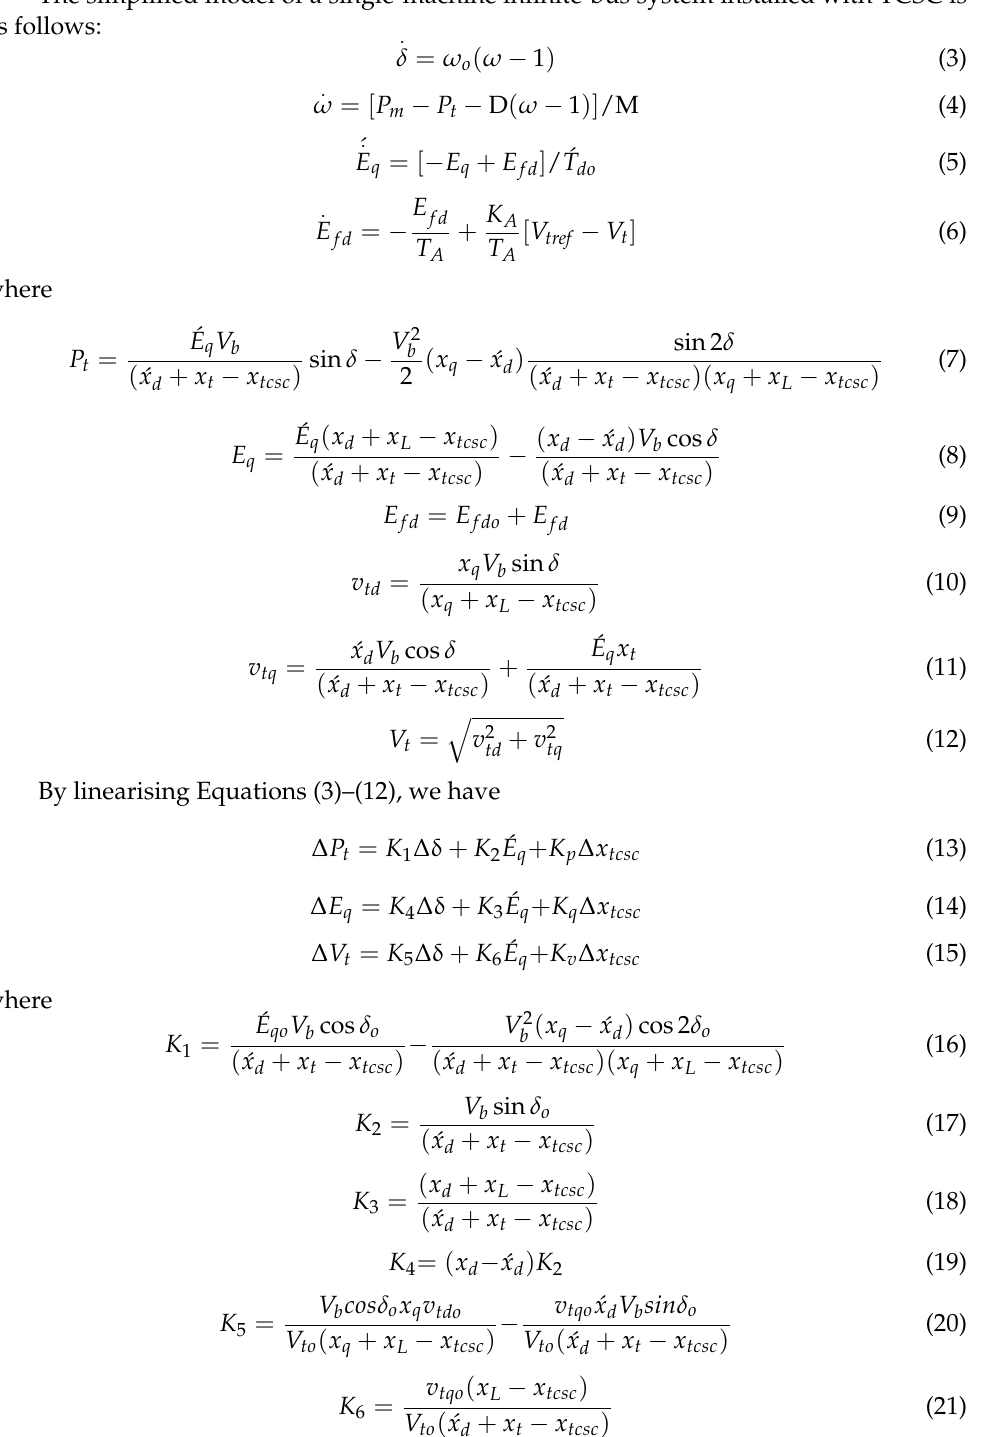
Figure 1. Single-machine infinite-bus power system installed with a TCSC.